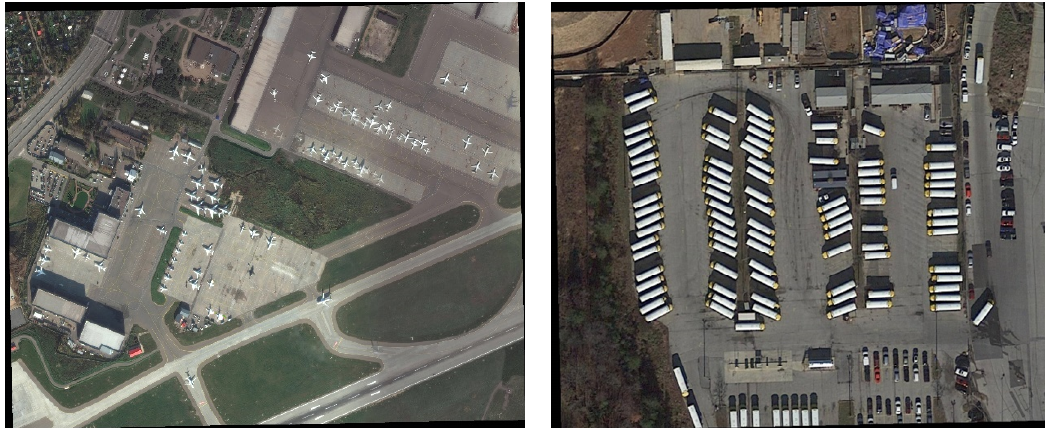
Figure 7. Sample images in DOTA.